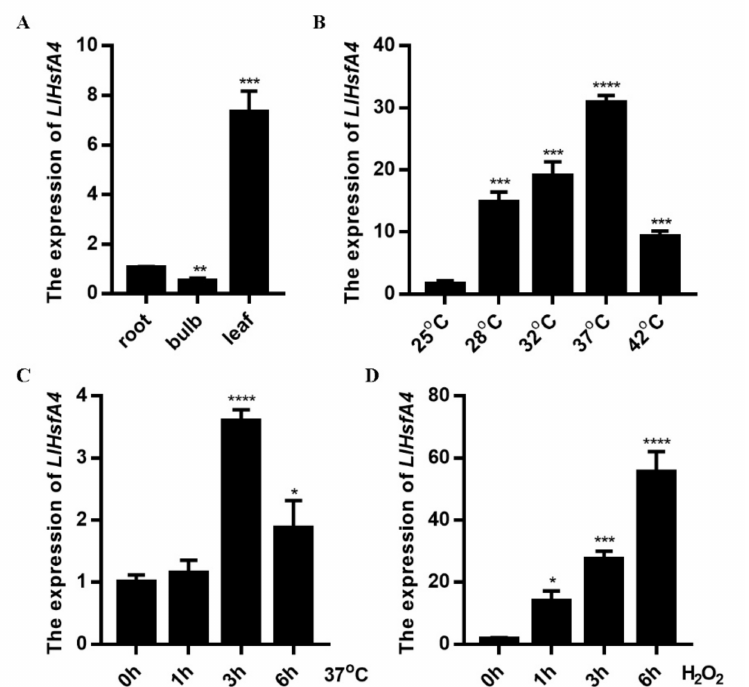
Figure 2. Expression analysis of HsfA4 in organs and heat stress condition by qRT-PCR. ( A ) Rel- ative expression of LlHsfA4 in roots, bulbs and leaves. ( B ) Lily seedlings were treated with heat temperatures of 28 ◦ C, 32 ◦ C, 37 ◦ C and 42 ◦ C. ( C ) Lily seedlings were treated using 37 ◦ C for 1 h, 3 h and 6 h. ( D ) Lily seedlings were treated using H 2 O 2 for 1 h, 3 h and 6 h. 18S rRNA was used as a control. Three independent experiments were performed each with three technical replicates, showing one experiment result. t -test analysis of variance was employed to identify treatment means that differed statistically. Samples with different letters are significantly different: * p < 0.05, ** p < 0.01, *** p < 0.001, **** p < 0.0001, Unmarked means